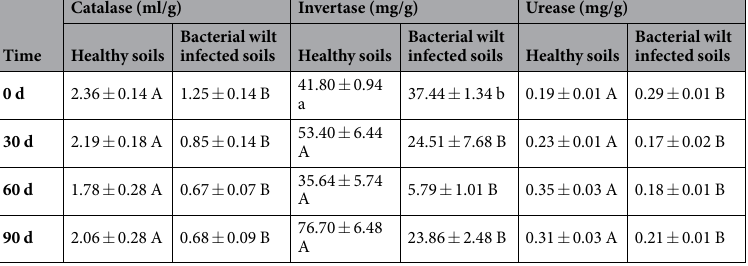
Table 1. Soil biological properties. All data are presented as the mean ± SE. Different capital letters and lowercase letters in the same line indicate very significant ( p < 0.01) and significant ( p < 0.05) difference between healthy and bacterial wilt infected soils, respectively.